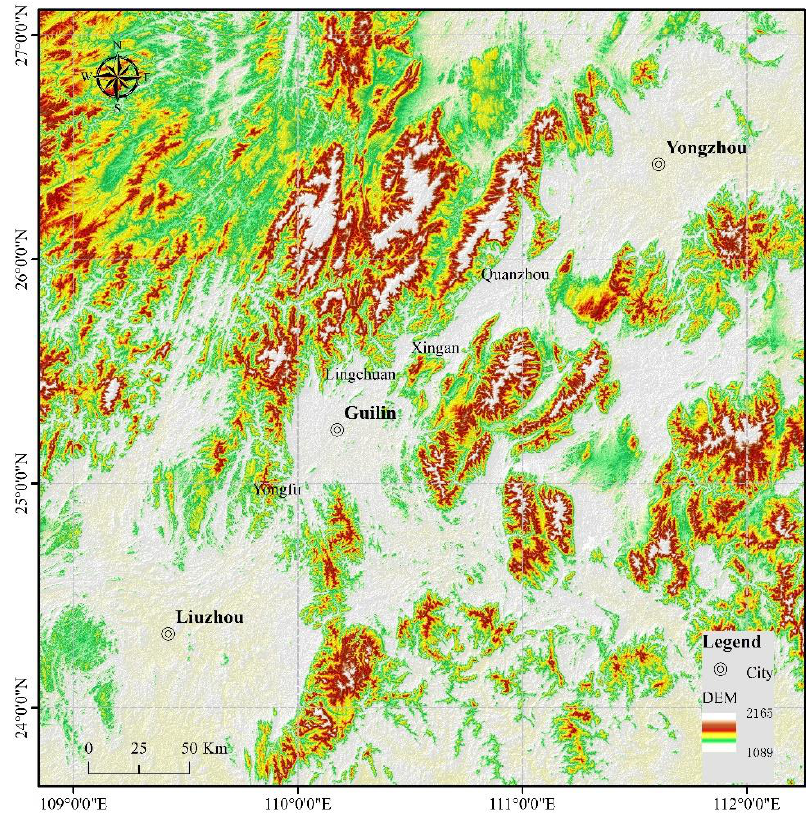
Figure 4. The terrain of Guilin.